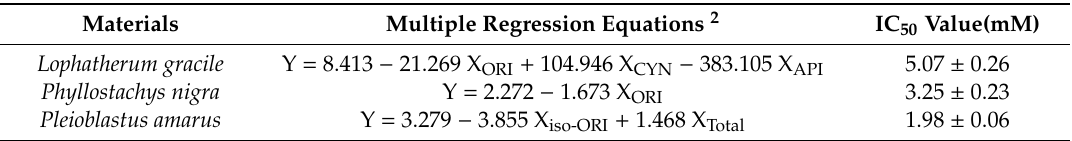
Table 6. The antioxidant IC 50 values of compounds and the correlations between contents and IC 50 values of